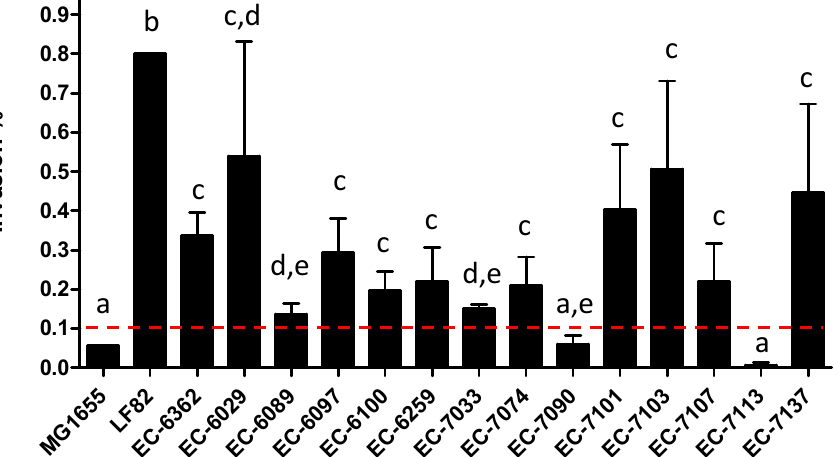
Figure 6. Strains of E. coli ( n = 16) different in their ability to invade I-407 cells. The invasion ratio (the number of intracellular E. coli divided by the total number of E. coli in the initial inoculum at a MOI of 10) after a 3 h incubation and a 1 h treatment with gentamicin was multiplied by 100 and thus expressed as a percentage. Strains with an invasion index ≥ 0.1% (the threshold indicated by a dotted line) are classified as AIEC. The data are quoted as the mean ± standard deviation from three determinations. The various letters indicate statistically significant differences ( p < 0.05) between strains in a one-way analysis of variance (the Mann–Whitney U